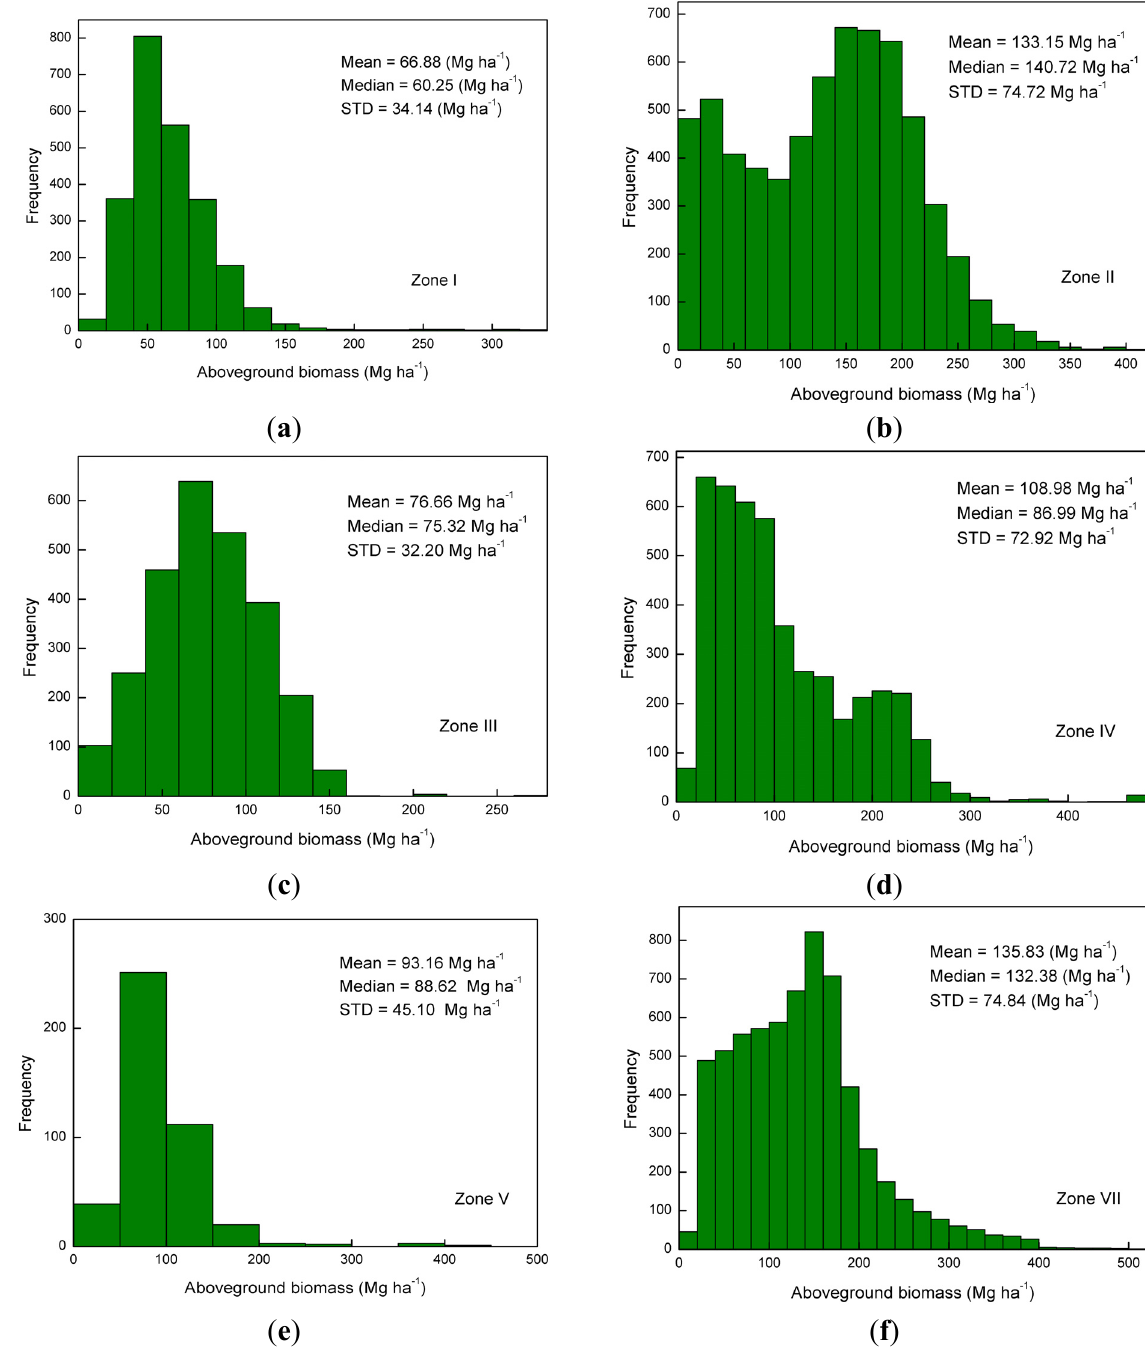
Figure 2. Distribution of forest aboveground biomass of field inventory data (listed in Table 1) in six forest zones: ( a ) cold temperate zone, ( b ) temperate zone, ( c ) warm